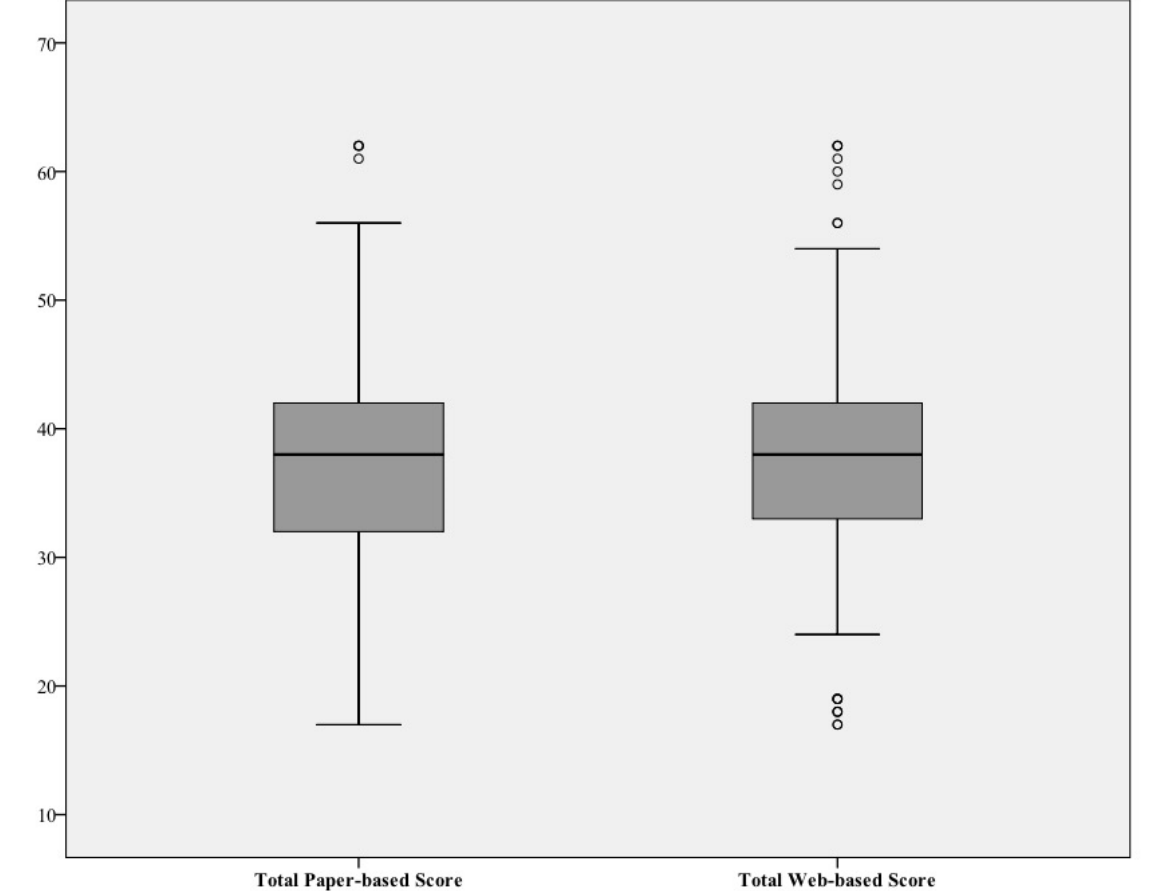
Figure 2. Box plot comparison of paper-based and web-based distribution of total scores.